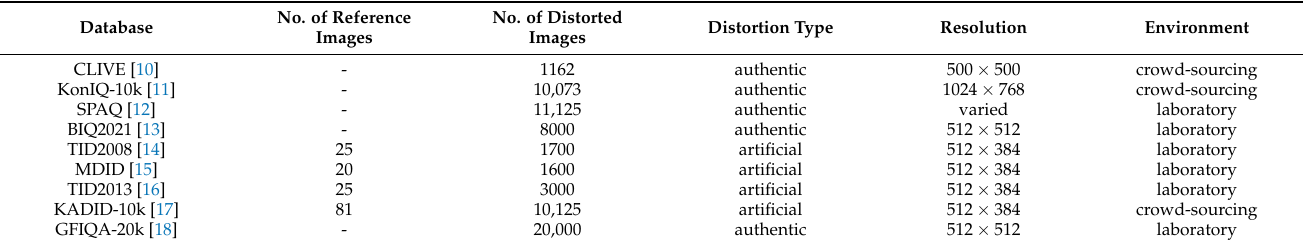
Table 1. Summary of the used benchmark IQA databases. The symbol # denotes the number of